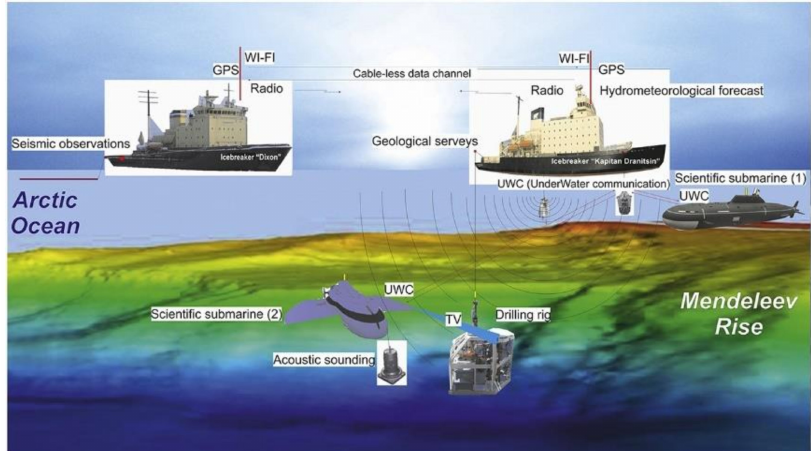
Figure 19. The technical process of rock sampling in Arctic expeditions